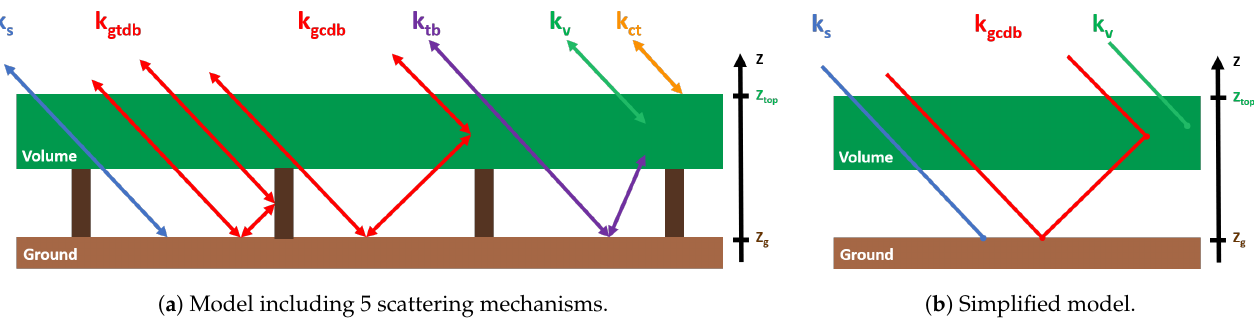
Figure 1. Illustration of the first-order backscattering terms contributing to the response of a volume lying above a